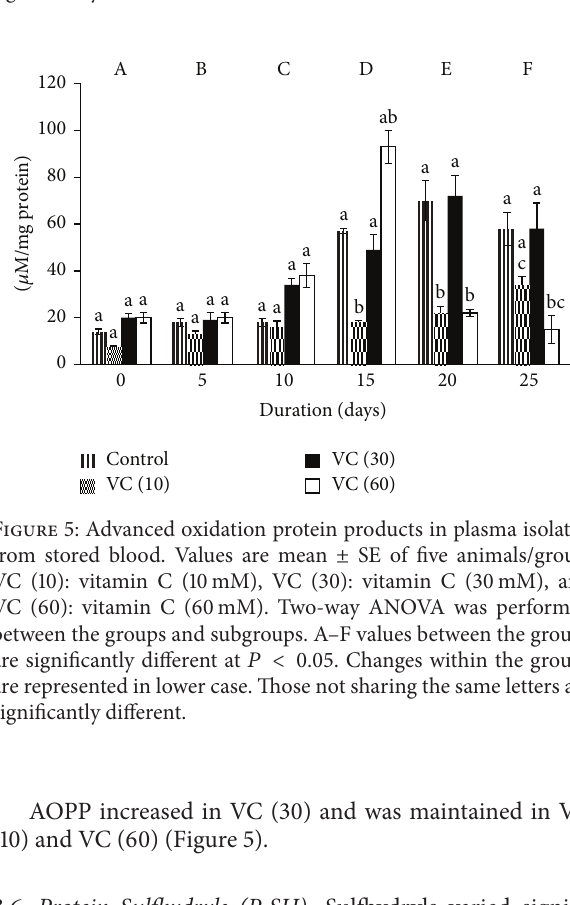
Figure 4: Protein carbonyls in plasma isolated from stored blood. Values are mean ± SE of five animals/group. VC (10): vitamin C (10mM), VC (30): vitamin C (30 mM). and VC (60): vitamin C (60 mM).Two-wayANOVAwasperformedbetweenthegroupsand subgroups. A–F values with different superscripts between groups are significantly different at 𝑃 < 0 . 05. Changes within the groups are represented in lower case. Those not sharing the same letters are significantly different.